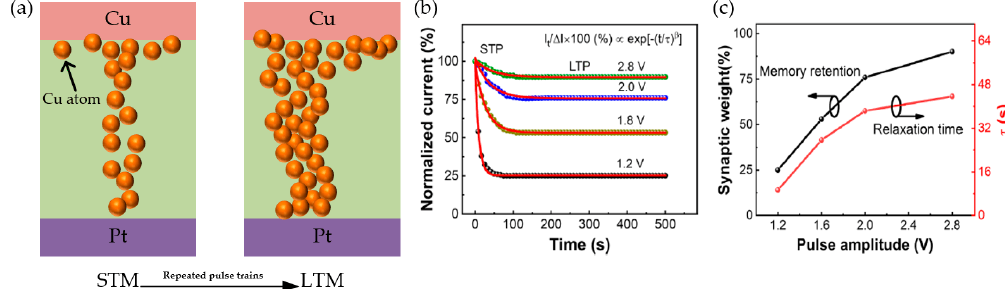
Figure 14. ( a ) Illustration of Cu atom dynamics of Cu/a-Si/Pt device during the transition from STM to LTM. ( b ) Relationship between normalized current response and retention time when the transferring process from STP to LTP occurred in Ag/SiO x :Ag/TiO x /p ++ -Si device. ( c ) Synaptic weight response to changes of pulse amplitude and relaxation time τ , reproduced from [155], with permission from Springer Nature, 2020.